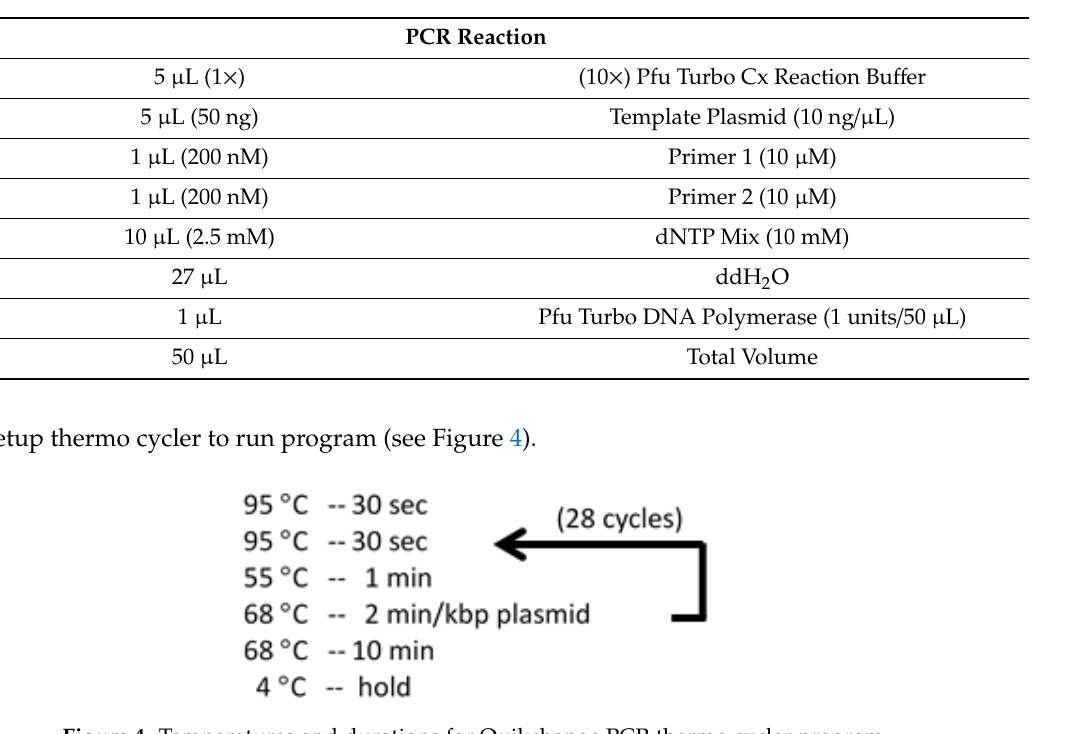
Table 1. Quikchange PCR reagents used in a generic reaction solution.